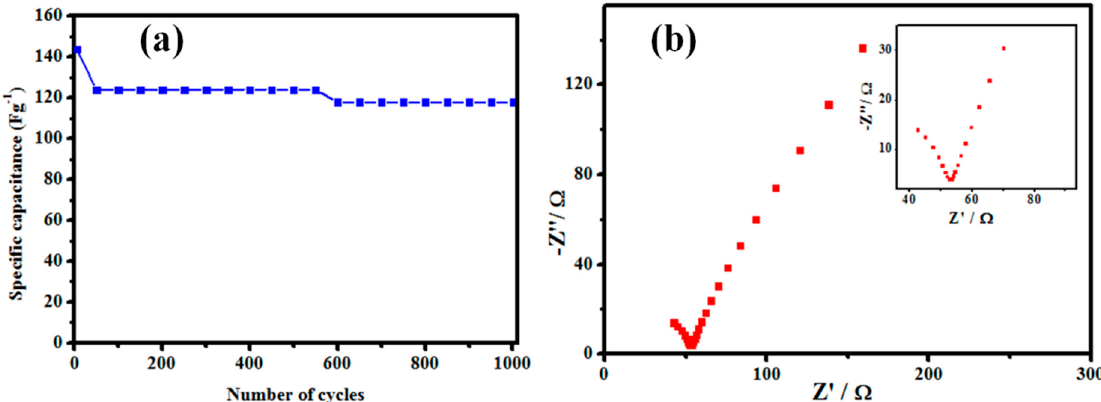
Figure 13. ( a ) The cycling performance of the OPLAC33%-PA at a current density of 60 µA/g; and ( b ) the Nyquist plot for the OPLAC33%-PA electrode using a sinusoidal signal of 10 mV over the frequency range from 0.01 Hz to 1 mHz. The real impedance is symbolized as Z ′ and the imaginary impedance as Z ″ .